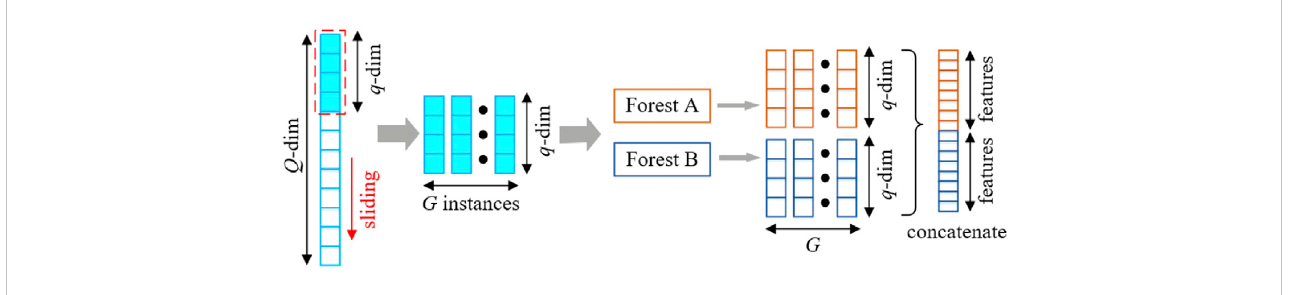
FIGURE 2 Structure diagram of multi-grained scanning.